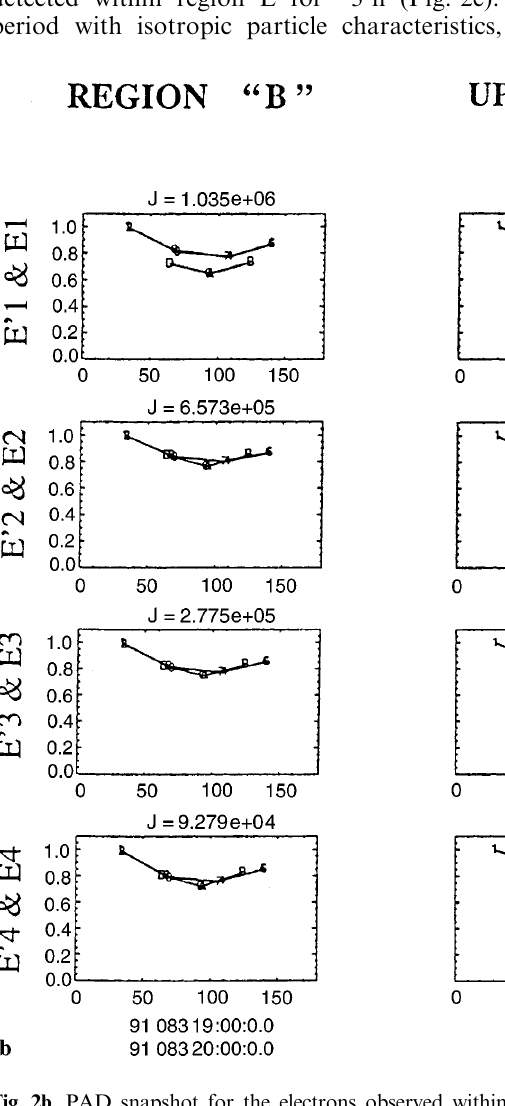
are also presented. Note that completely di(cid:128)erent anisotropies are observed as Ulysses proceeds from the upstream into the downstream region of the